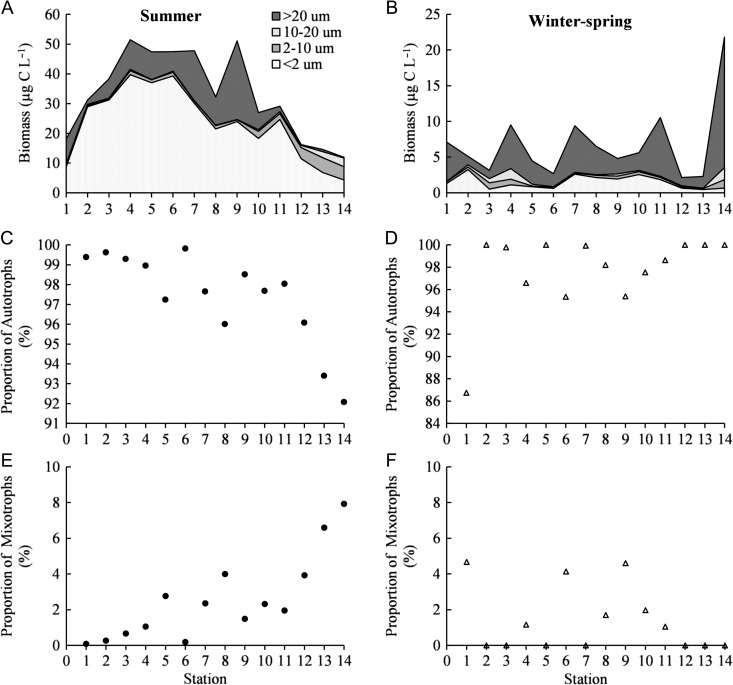
Phytoplankton biomass divided into four size groups (<2, 2–10, 10–20 and >20 µm) (AandB), relative proportion (%) of autotrophs (C andD) and mixotrophs (E and F) during summer and winter–spring sampling periods.